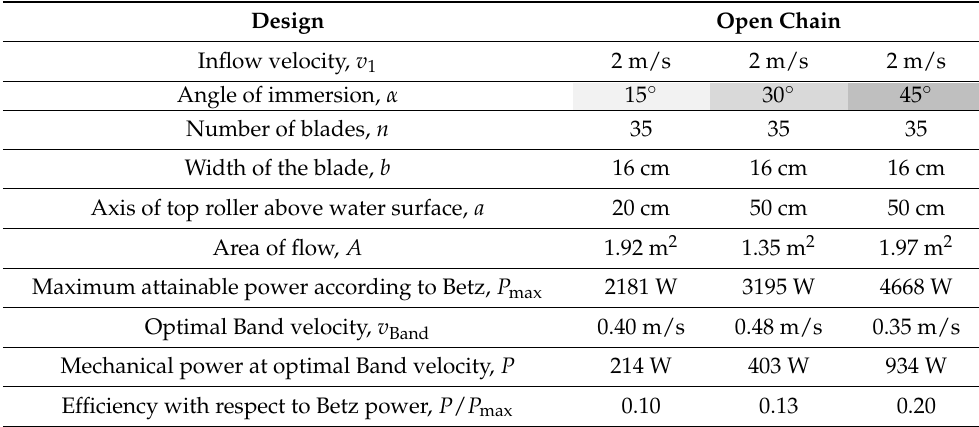
Figure 11. Mechanical power for Result summary I. Table 3. Result summary II for Open-Chain